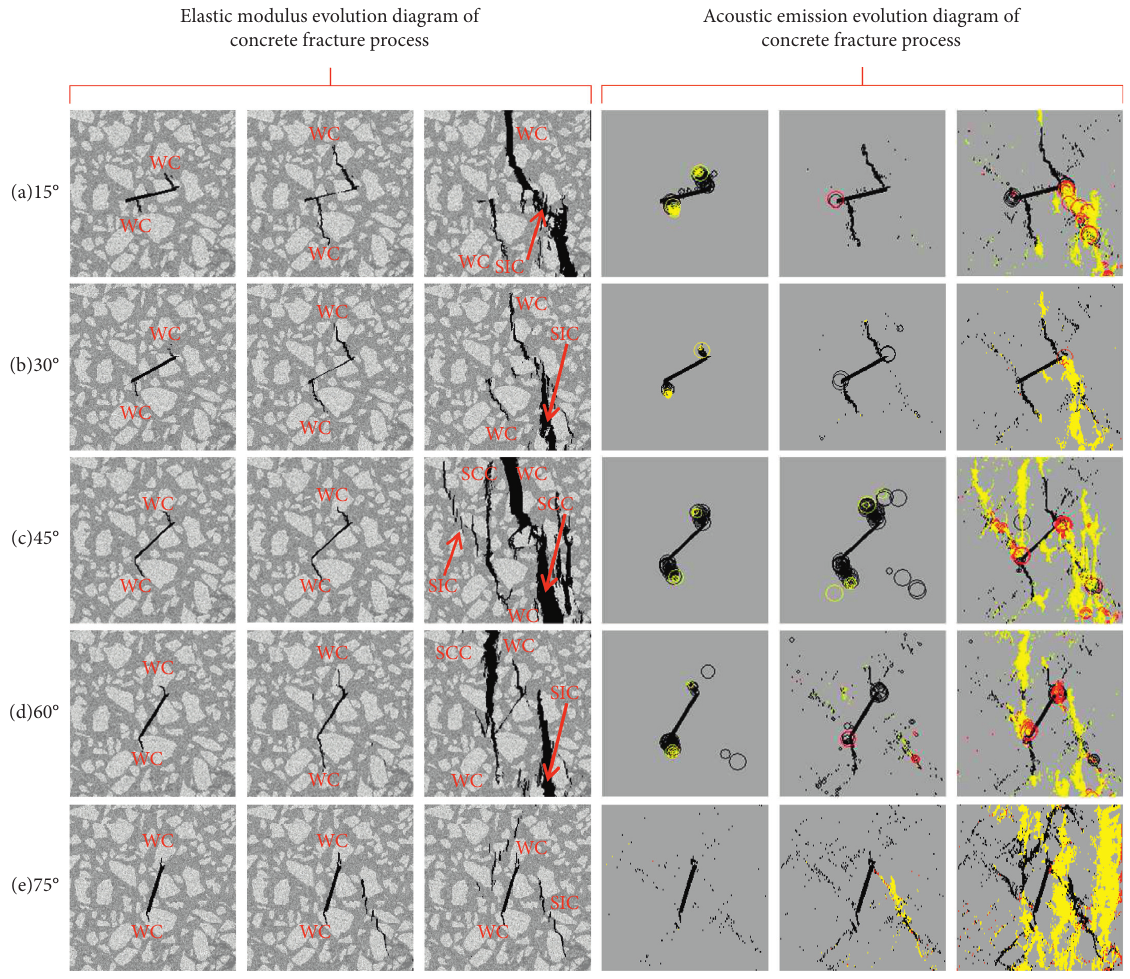
Figure 7: Failure process and acoustic emission evolution diagram of cracked concrete at different inclination angles.